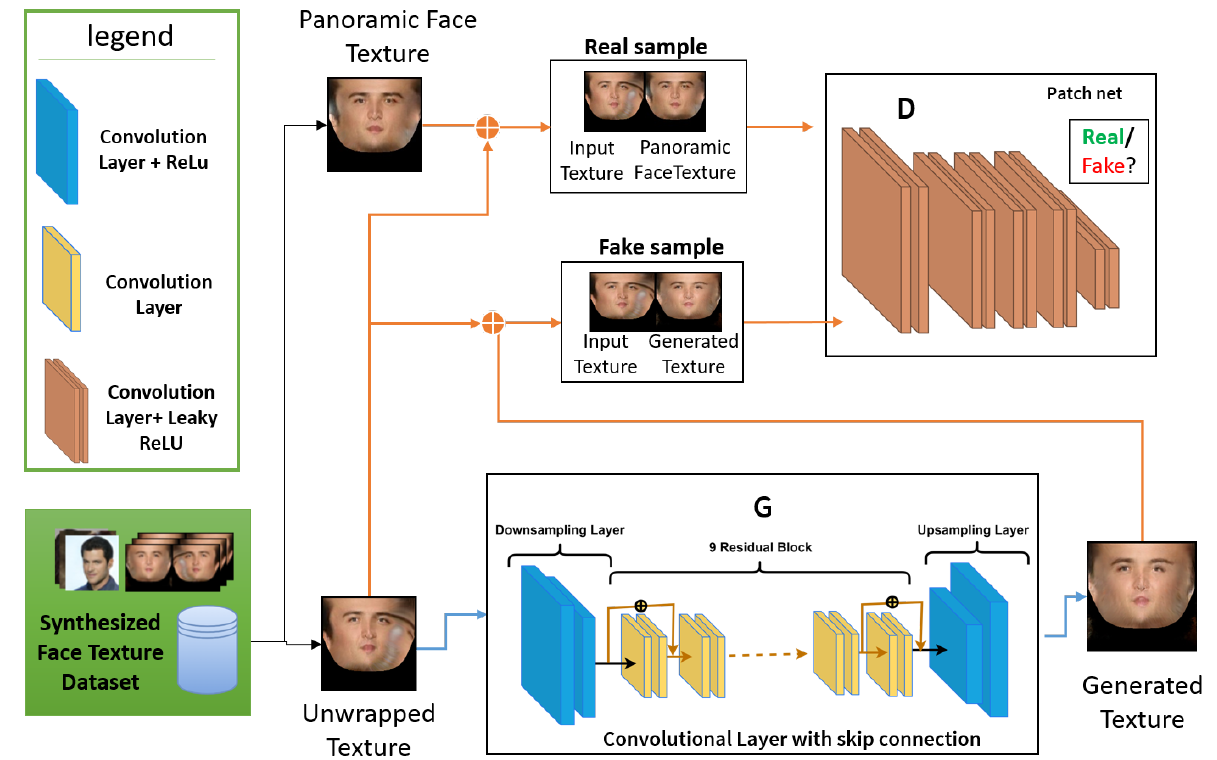
Figure 9. Structure of the texture translator network.